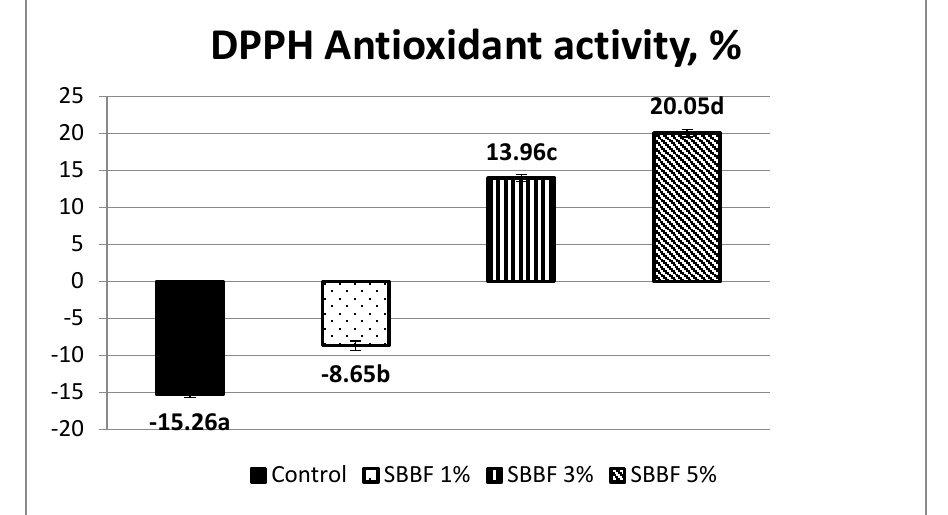
Figure 1. DPPH antioxidant activity (%) of the wheat bread samples made with and without sea buckthorn berry flour (error bars represent standard deviation, different letters indicate significantly different results).